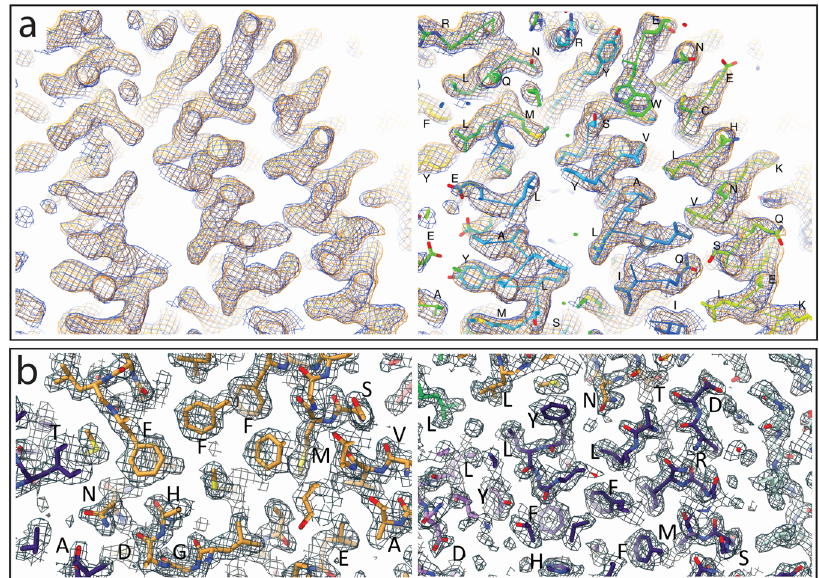
Fig. 3 Representative ApoF amino acids show no difference between the UVC-treated ApoF cryo-EM map and the crystal structure. a A comparison of the UVC-treated ApoF map (blue) with a previously published, untreated sample map (orange; EMD-3853) (left). The same map UVC-treated ApoF map superimposed with the fi tted model (PDB-5n27) con fi rms no differences (right). b Close-up view of UVC-treated ApoF map with same fi tted model as in a , highlighting no difference between representative amino acids that may be impacted by UVC